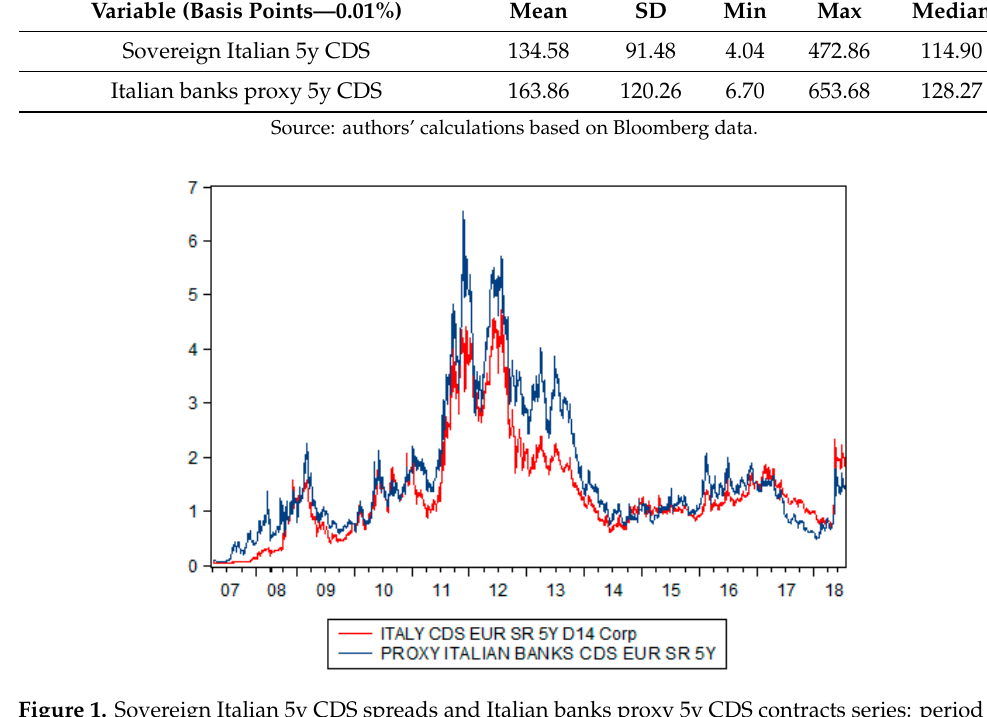
Figure 1. Sovereign Italian 5y CDS spreads and Italian banks proxy 5y CDS contracts series: period Q2 2007–Q3 2018. Source: authors’ calculations in Eviews 10 based on Bloomberg data. Table 1. Descriptive statistics –April 2007 to September 2018 (2859 Obs.).